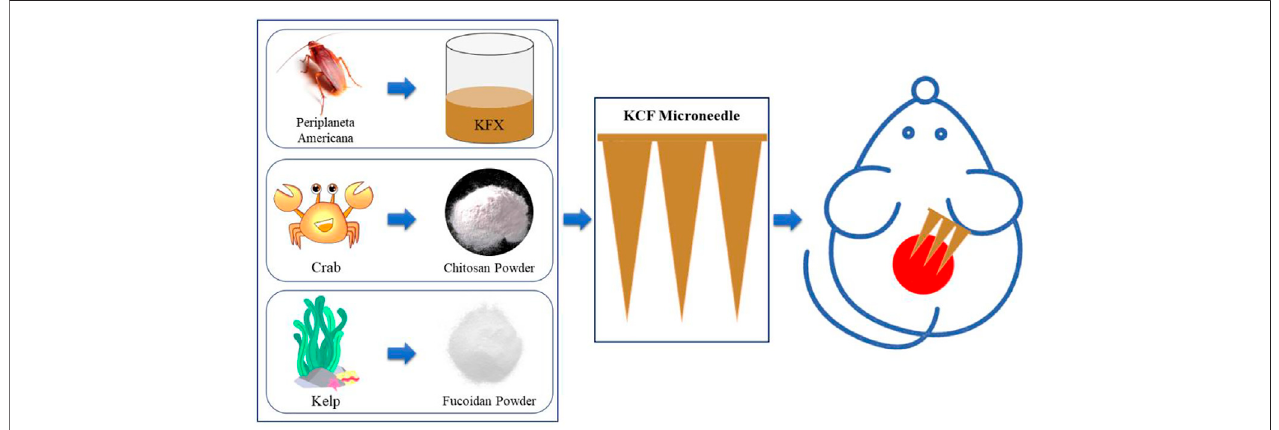
FIGURE 1 | Schematic diagram of sample preparation for KCFMN patches and its application in wound